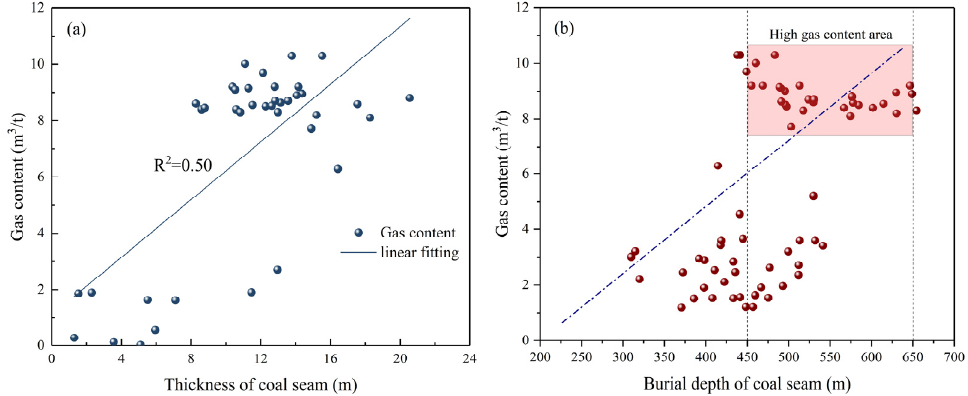
Figure 3. The relationship between gas content and thickness of coal seam, burial depth: ( a ) thickness of coal seam; ( b ) burial depth of coal seam.